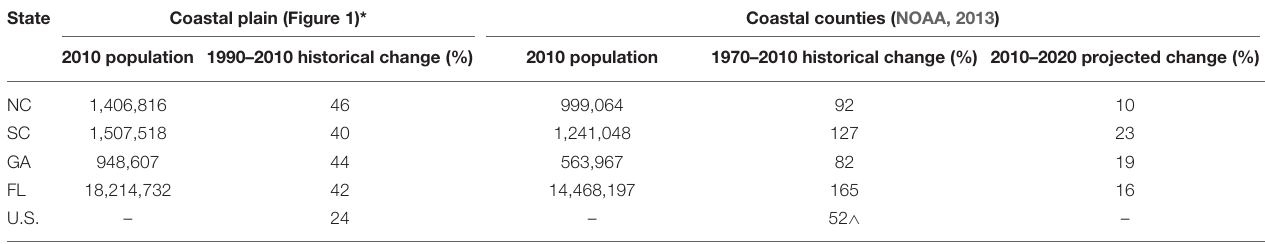
TABLE 1 | Population change in the southeastern U.S. coastal plain states.